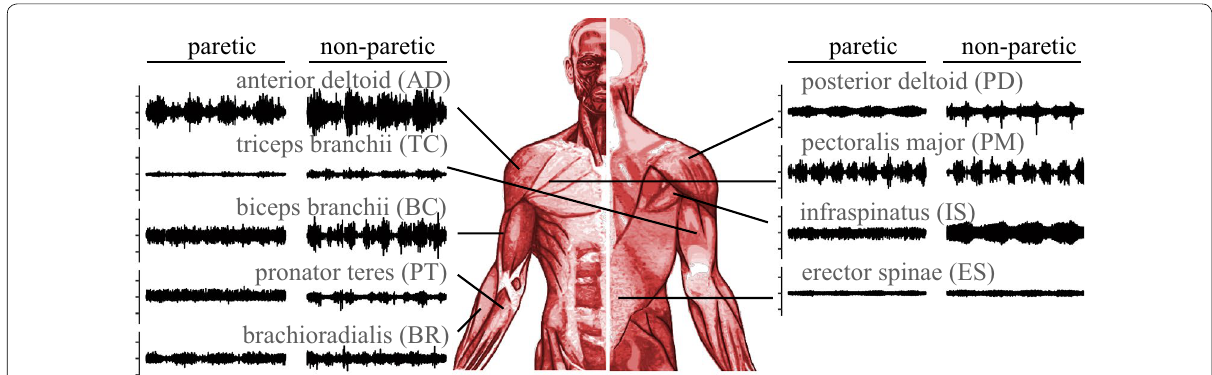
Fig. 3 Placement of the EMG sensors and corresponding EMG signals during four cycles of in-phase motion. The EMG signal duration is 20 s and one tick in amplitude is 20